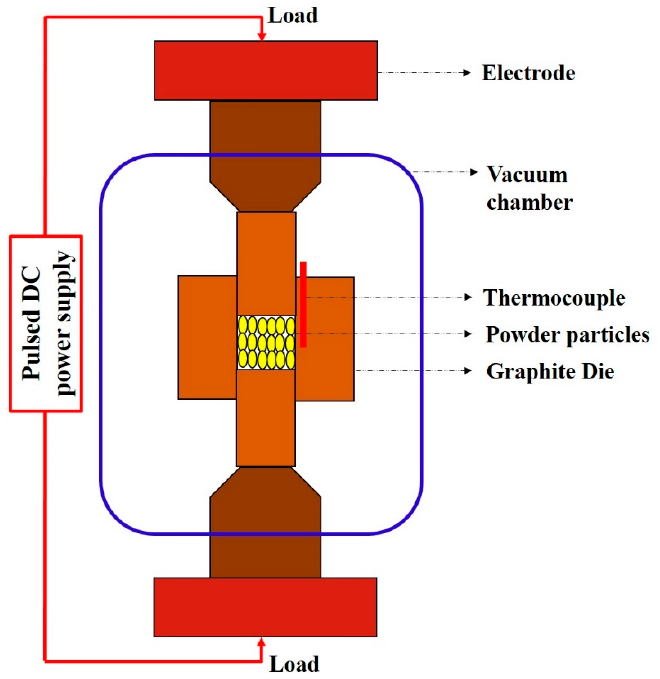
Figure 2. Schematic representation of Spark plasma sintering.